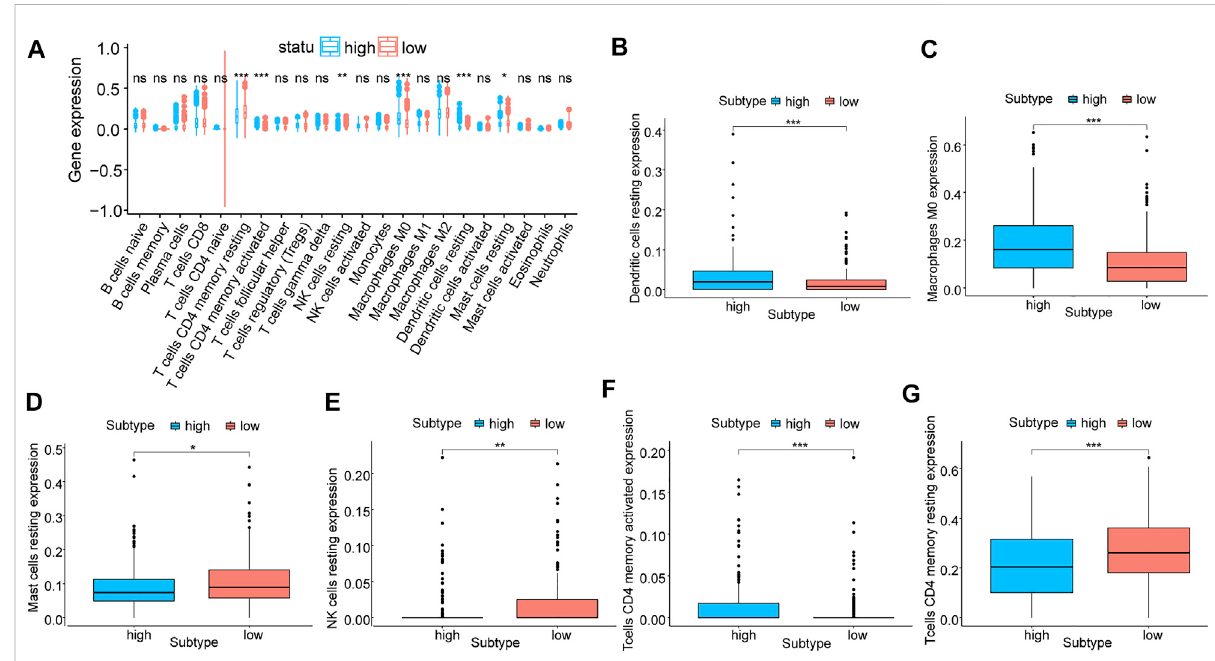
FIGURE 6 Correlation analysis of prognostic models and immune cells. (A) Differential analysis of the degree of immune cell in fi ltration in prognostic model subgroups, blue for high-risk and red for low-risk; (B – G) : Differential analysis of the degree of in fi ltration of six types of immune cells, including resting dendritic cells, M0 Macrophages, resting mast cells, resting NK cells, activated CD4 T cells, and resting CD4 T